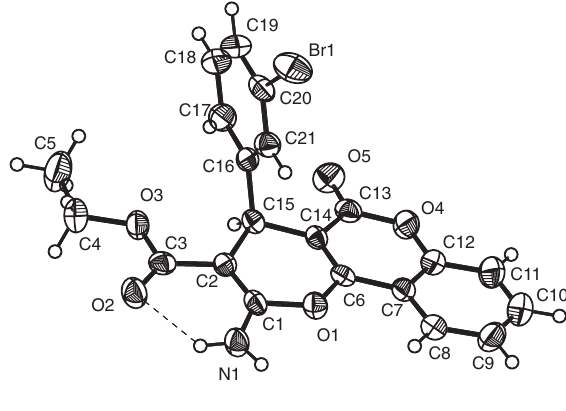
Table 1: Crystal collection and handling.